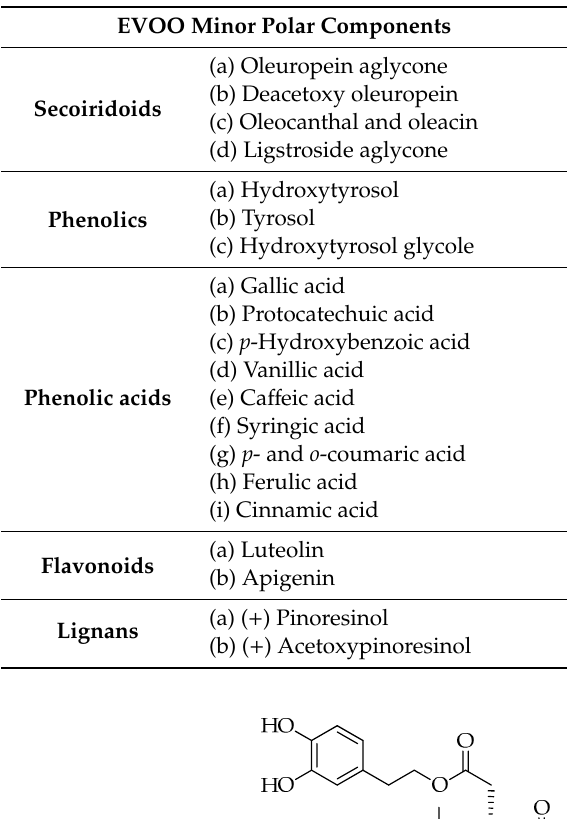
Table 1. Subclasses of EVOO minor polar components